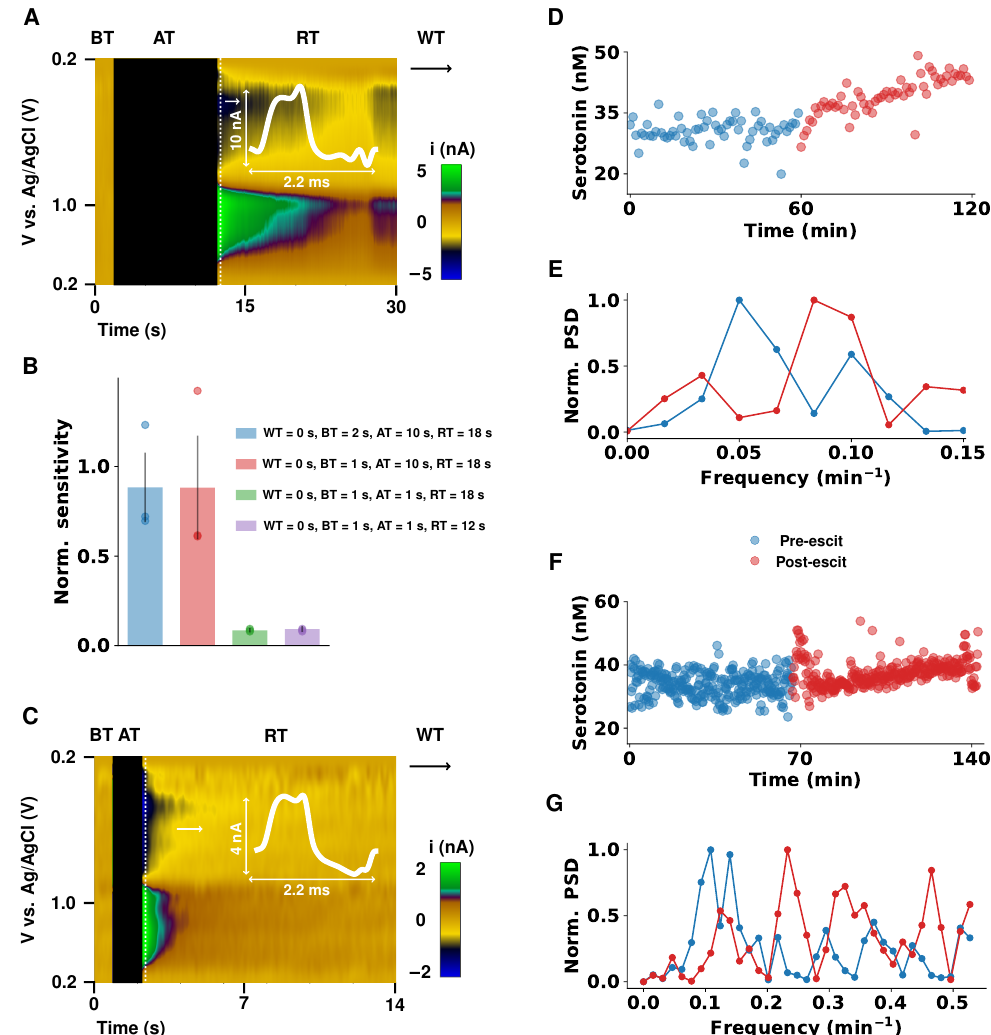
Figure 4. Comparison of conventional FSCAV with fast FSCAV acquisition (14 s sampling period). ( A ) Representative example of in vivo FSCAV color plot from the CA2 region of a mouse hippocam- pus, using the conventional FSCAV method with inset cyclic voltammogram. Labels of the different steps of the FSCAV acquisition are as follows: background time (BT), adsorption time (AT), redox time (RT), and wait time (WT); ( B ) the ratio of sensitivity between conventional FSCAV (depicted in (A)) and fast FSCAV, with parameters given in the legend (n = 3 electrodes); ( C ) a representative example of in vivo FSCAV color plot from the CA2 region of a mouse hippocampus, using the fast FSCAV method (WT = 0 s, BT = 1 s, AT = 1 s, and RT = 12 s) with inset cyclic voltammogram; ( D ) concentration vs. time from an FSCAV acquisition, drawn from the CA2 region of the hippocam- pus of an anesthetized mouse, pre- and post-escitalopram administration (10 mg/kg), using the conventional FSCAV method; ( E ) a normalized power spectra density (PSD) for the representative acquisition given in ( D ); ( F ) concentration vs. time from an FSCAV acquisition drawn from the CA2 region of the hippocampus of an anesthetized mouse, pre- and post-escitalopram administration (10 mg/kg), using the fast FSCAV method shown in ( C ); and ( G ) a normalized power spectra density (PSD) for the representative acquisition given in ( F ). The time series were band-pass filtered to remove the slow-frequency effects of escitalopram and the high-frequency noise. The concentration vs. time trace shown in ( D ) was filtered following the filtering paradigm described in Materials and Methods. For the time series in ( F ), the high cutoff frequency was, in this case, set to 0.02 Hz (60% of Nyquist frequency), while the lower cutoff frequency was maintained at 0.0008 Hz. The higher acquisition frequency allows the study of higher spectrum